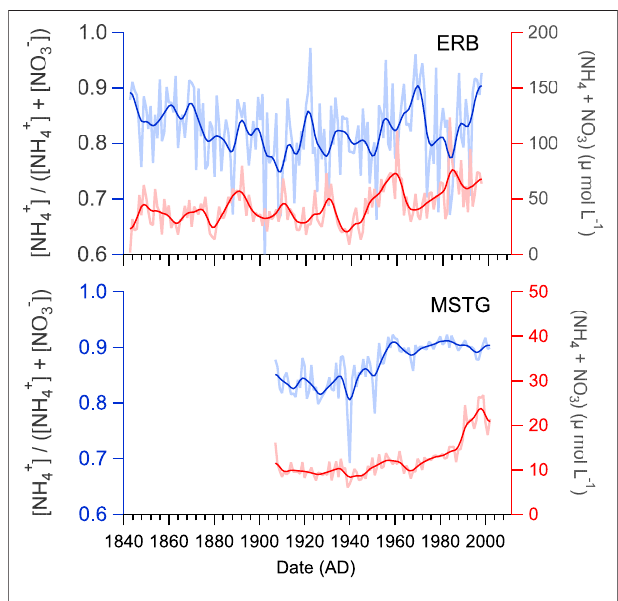
FIGURE5| Thepro fi lesof[NH 4+ ]/([NH 4+ ]+[NO 3 − ])and(NH 4+ +NO 3 − )inERB and MSTG ice cores (Hou et al., 2003; Zhao et al., 2011). The light lines are original data, and the dark lines are 7-point Gaussian smoothing of the original